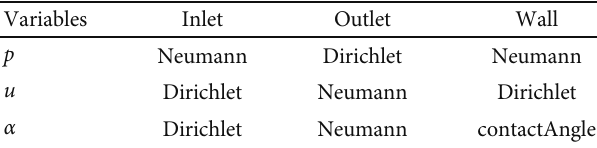
Table 1: Boundary